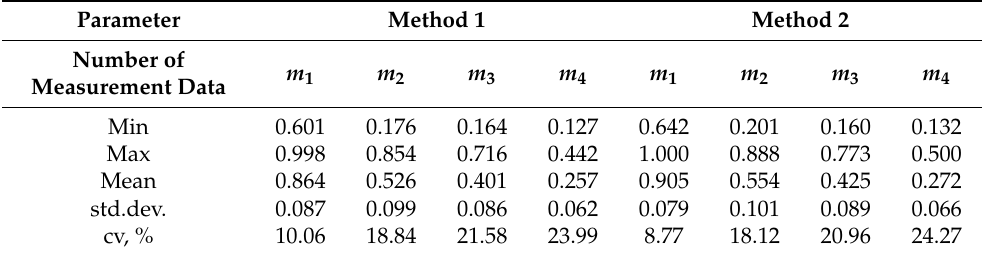
Table 5. Ratio Je / Jm characterizing the state estimation for load level V 0.5 .